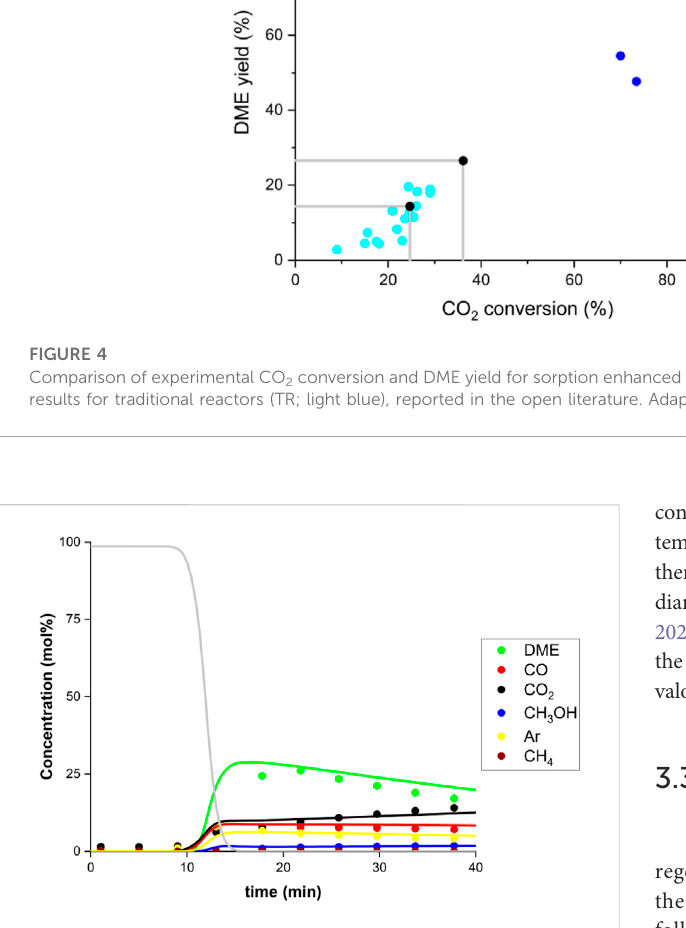
FIGURE 5 Breakthrough experiment at 220 ° C and 25 bar(a) for a CO 2 feed with stoichiometric hydrogen, with argon tracer (24.5% CO 2 , 73.6% H 2 , 1.9% Ar, GHSV 93 h -1 ), (dots; DME (green), CO (red), CO 2 (black), methanol (blue), argon (yellow), methane (brown), nitrogen (grey)) and model prediction